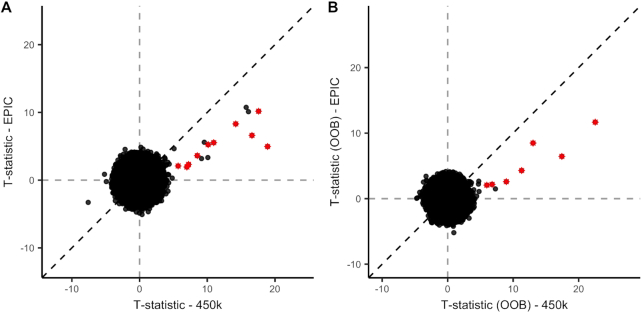
Comparison between test-statistics from the EWAS in the 450k cohort and test-statistics from the EWAS in the EPIC cohort. Probes flagged as mapping to the C9 repeat (≥14 bp inexact match) and that were significant in the 450k EWAS are highlighted. (A) T-statistics from the EWAS in the EPIC cohort (y-axis) compared with t-statistics from the EWAS in the 450k cohort (x-axis). (B) T-statistics from the EWAS on OOB β-values in the EPIC cohort (y-axis) compared with t-statistics from the EWAS on OOB β-values in the 450k cohort (x-axis).